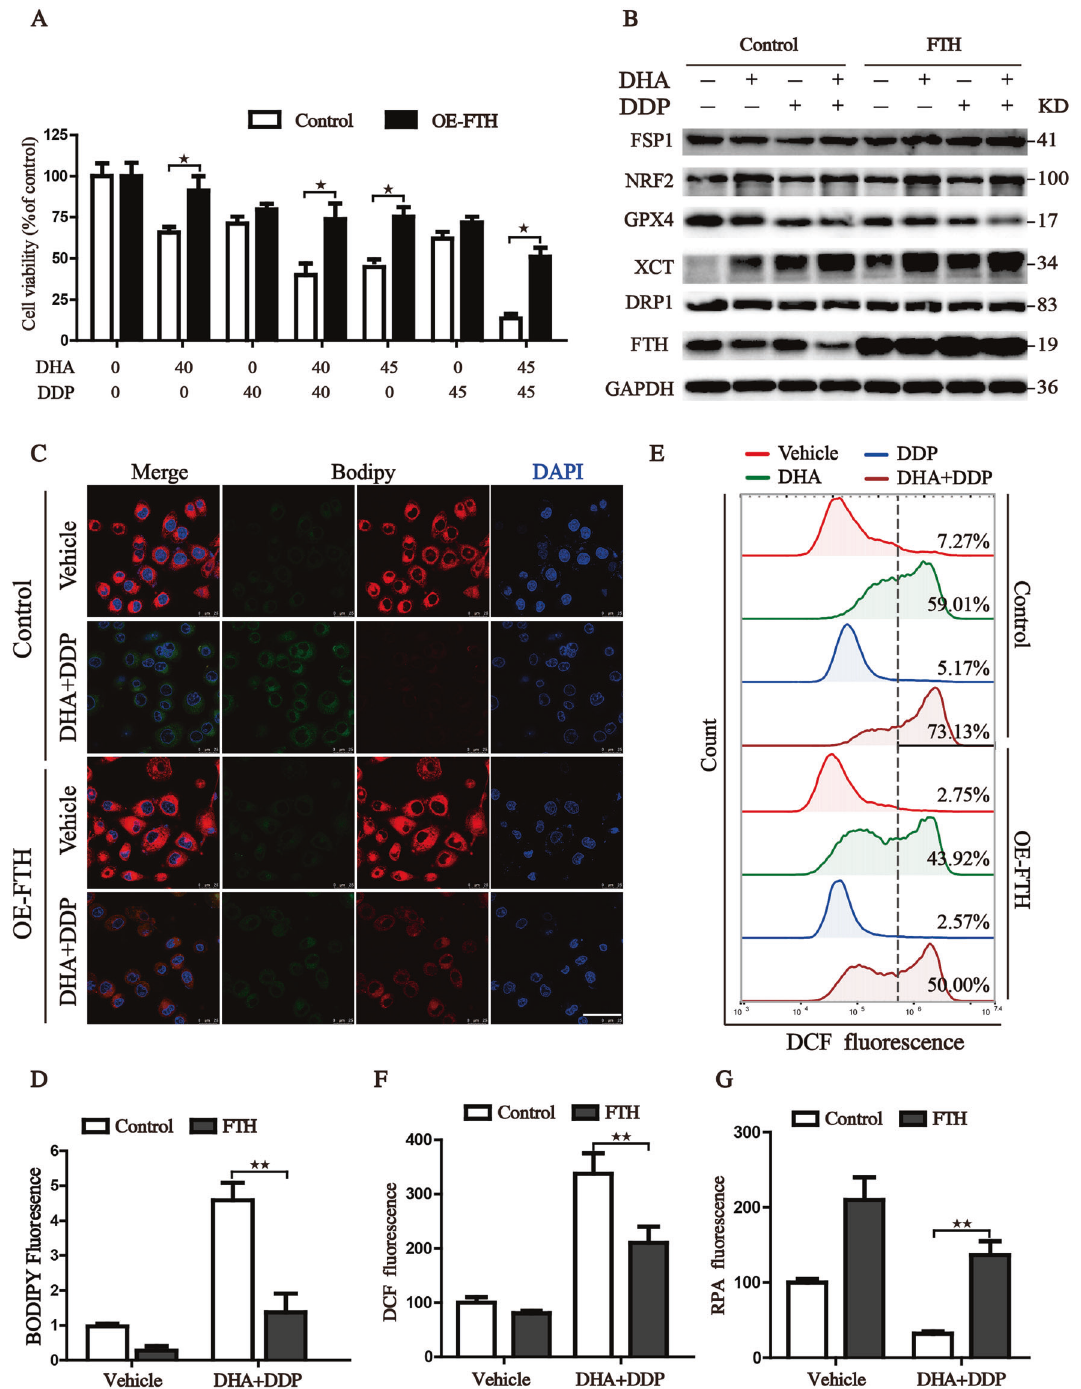
Fig. 7 Reconstituted expression of FTH contributes to the tolerance of DHA/DDP-induced ferroptosis. A PANC1 cells were treated with various concentrations of DHA and DDP for 24 h, followed by CCK8 assay. B Proteins isolated from the treated cells were assayed by western blot to detect the expression of ferroptosis-related proteins. C , D Indicated cells were stained with BODIPY C11 probe for the assessment of lipid ROS production and observed under the confocal laser microscope. Scale bars: 50 μ m. Cells with indicated treatment were stained with RPA and DCF-DA probe for 30 min and followed by fl ow cytometry to assess intracellular Fe 2 + and ROS level ( E – G ) (values represented mean ± SD. ★ P < 0.05, ★★ P < 0.01 versus selectively targeted by erastin through inducing ferroptosis molecular mechanism of ferroptosis. Increasing evidence has [28, 29]. Activation of the RAS/RAF-MEK/ERK signaling pathway revealed that inducing ferroptosis could act as a promising is required for erastin-induced cell death, while restraining RAS or therapeutic strategy and eliminate the resistance of cancer cells to its downstream signaling molecules reverses the lethality against drug-induced apoptosis [27]. The mutated RAS family genes are cancer cells [30, 31]. the most common oncogenes in pancreatic cancer that could be